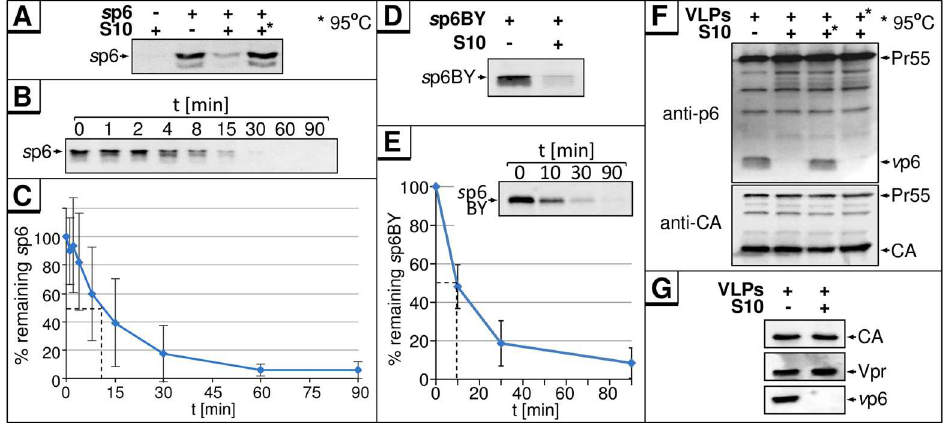
extract was heat-inactivated (95˚C, 5 min) prior to incubation( * ). (B) 100 ng s p6 were incubatedwith 5 μ g S10 extract for the times indicatedat 37˚C. (C) Amounts of p6 were quantified for four independently performed experiments. Values represent the arithmetic mean ± SD. (D) 10 ng s p6BYwere incubatedwith 5 μ g S10 extract for 30 min at 37˚C. s p6BYwas detected by measurement of fluorescence excitation. (E) 10 ng s p6BY were incubatedwith 5 μ g S10 extract for the times indicated. Band intensities were quantified with AIDA for seven independently performed experiments. Values represent the arithmetic mean ± SD. (F) VLPs produced in HEK293T cells transfected with the subgenomic HIV-1 expressionplasmid p Δ R[11] were isolated, lysed with 0.5% Triton X-100 and incubatedwith 5 μ g S10 extract for 30 min at 37˚C. ( * ) S10 extract, or VLP lysate, was heat-inactivated for 5 min at 95˚C prior to incubation. Sampleswere analyzedby Western blotting. (G) VLPs were producedand treated as describedin (F) and analyzedfor Vpr content.